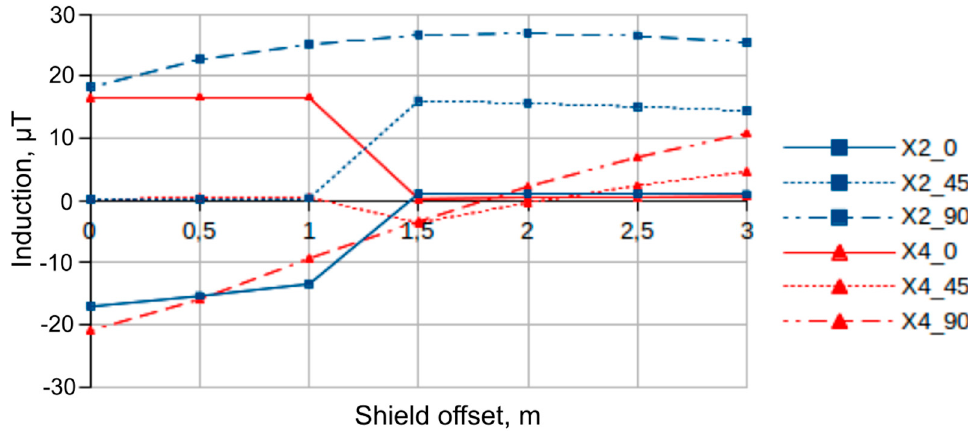
Figure 7. Dependences of magnetic induction vector X-axis components in ferroprobe on the tun- neling shield parallel displacement for angle values between longitudinal axes of 0, 45 and 90 de- grees ("X2" and "X4" curves correspond to "D2" and "D4" elements).